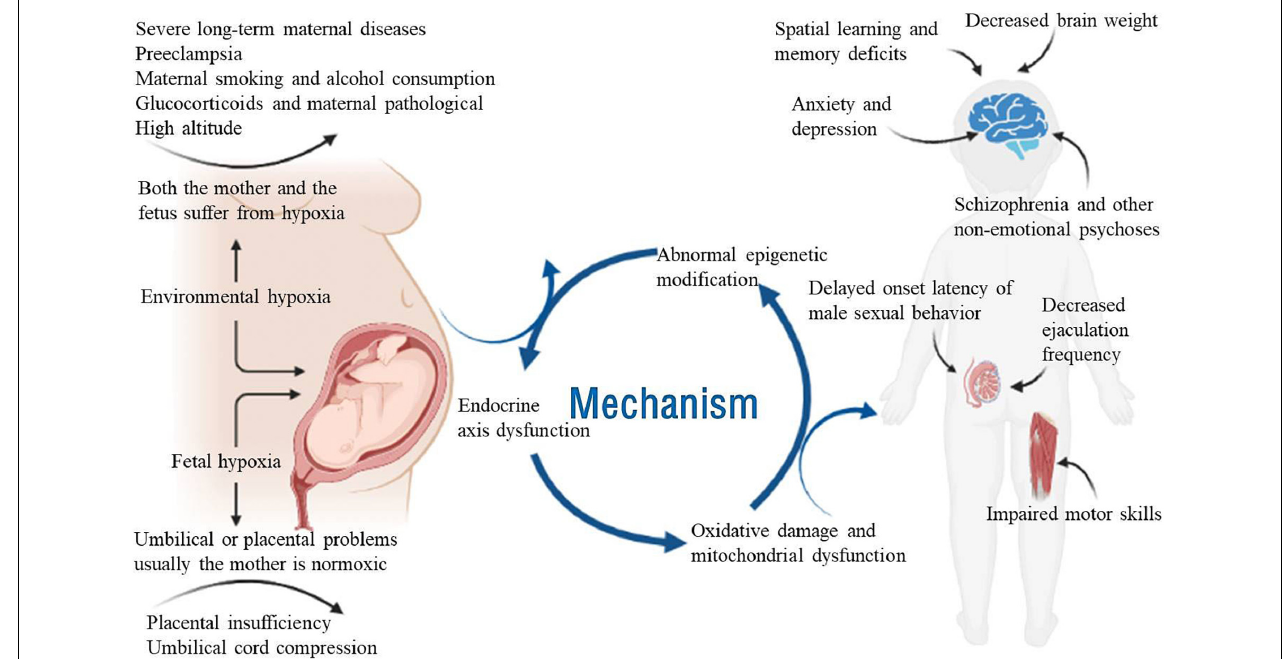
FIGURE 1 | Schematic diagram of the effects of prenatal hypoxia on neurological development and related diseases. Adversity during pregnancy, such as chronic maternal illness, preeclampsia, high-altitude pregnancy, placental dysfunction, and umbilical cord compression, can cause prenatal hypoxia. Adequate oxygen is essential for the growth and development of the fetus. Prenatal hypoxia affects fetal growth and development in terms of epigenetics, endocrine axis dysfunction and mitochondrial oxidative damage. Prenatal hypoxia also causes dysfunction of the offspring after birth, such as learning and memory disorders, male sexual dysfunction, motor dysfunction and emotional